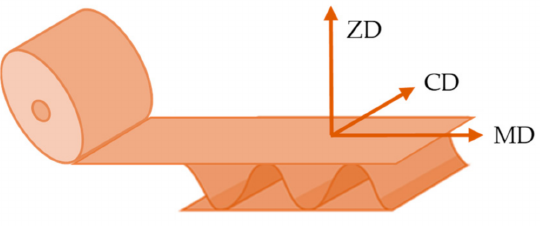
Figure 2. Machine direction (MD), cross direction (CD) and through-thickness direction (ZD). Reprinted with permission from ref. [12]. Copyright 2021